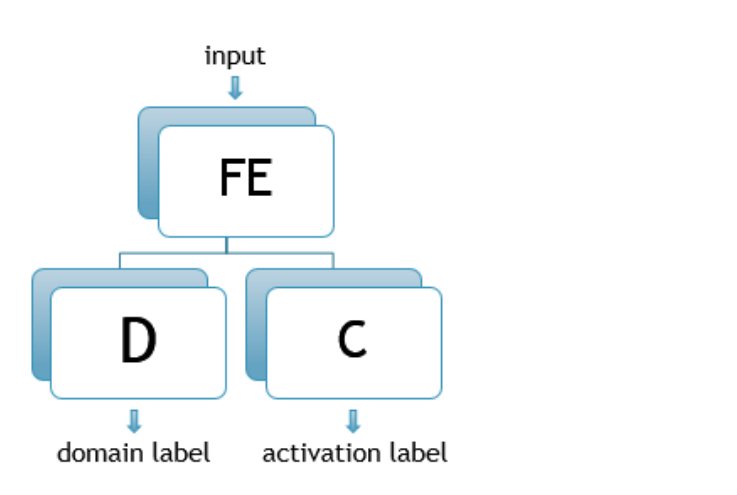
Figure 1. DANN architecture (FE—feature extractor, C—classifier, D—discriminator). Table 1. Feature extractor’s layers.